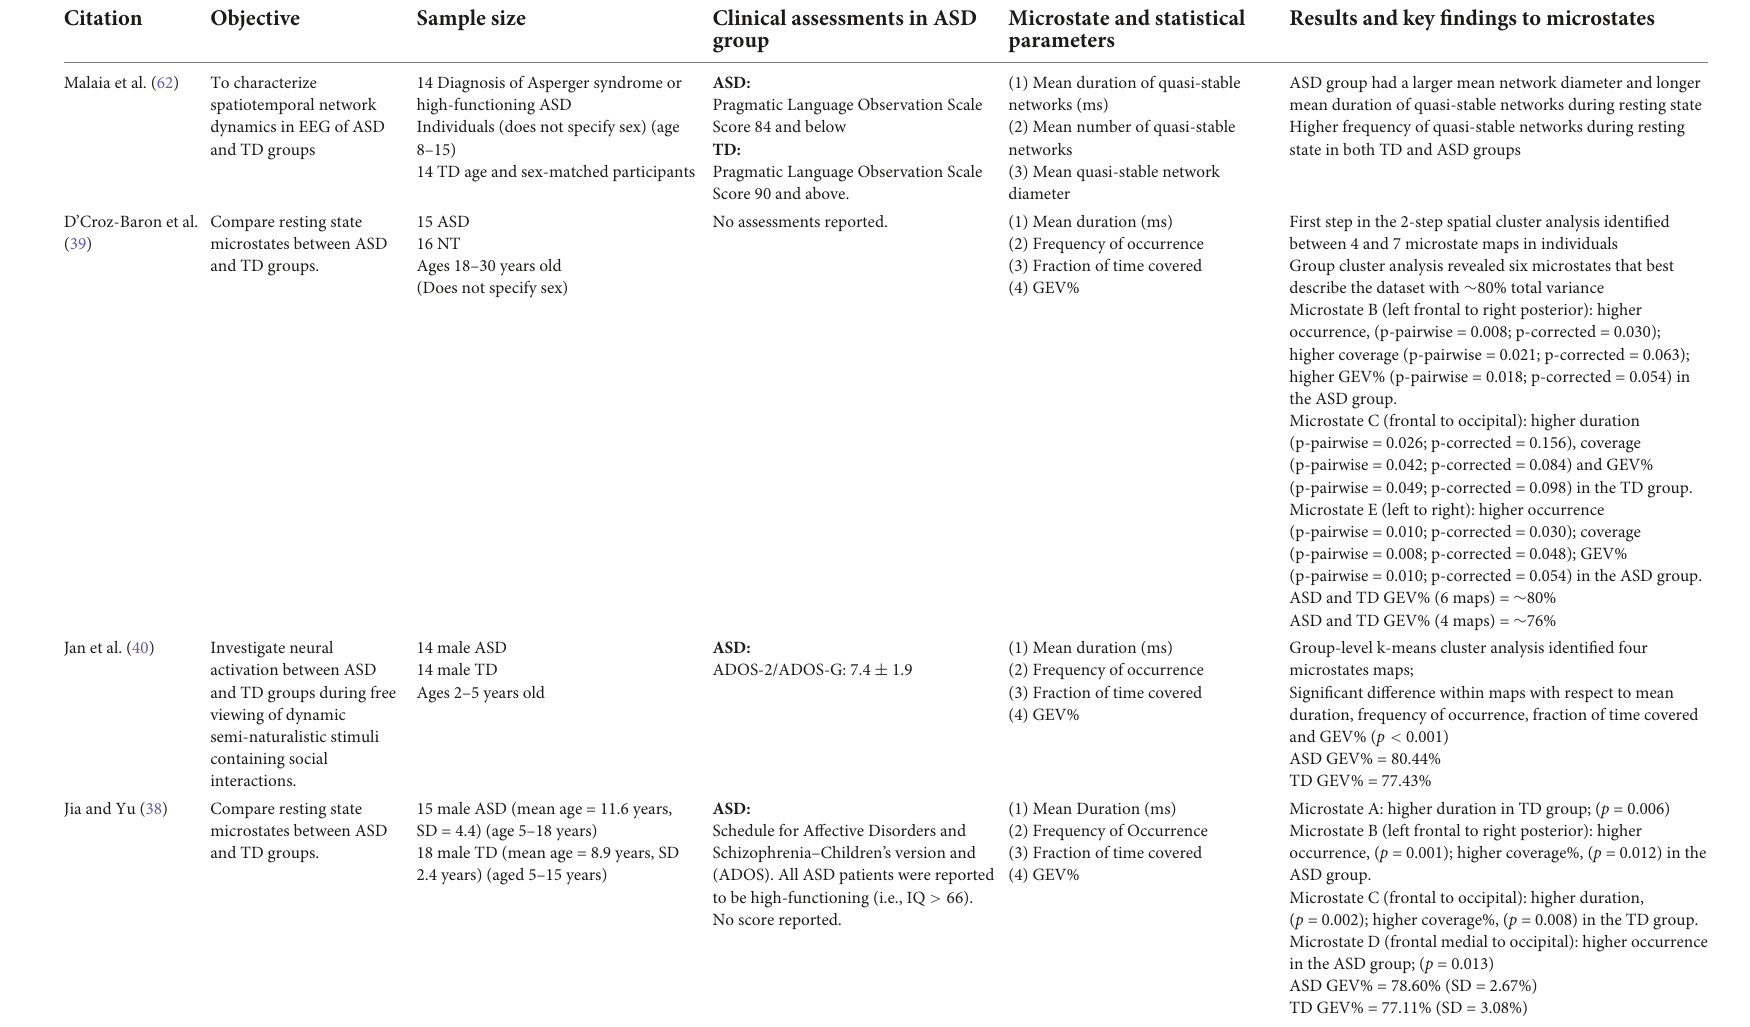
TABLE 1 Summary of key findings related to microstate analysis in ASD